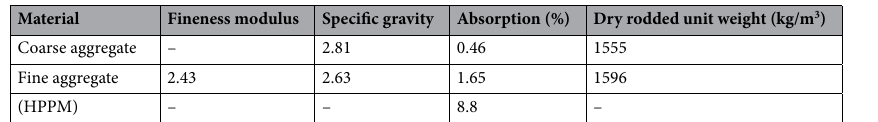
Table 2. Material